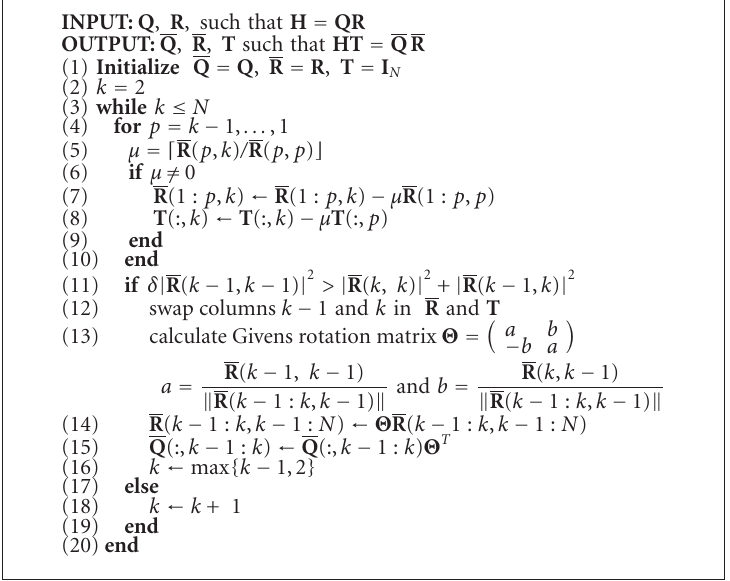
Algorithm 1: LLL